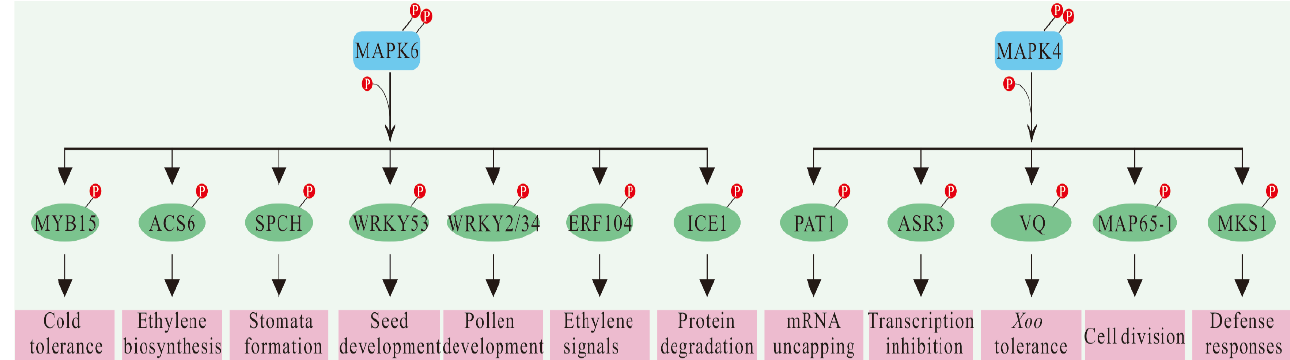
Figure 4. Schematic diagram for MAPKs and substrates in multiple plant signaling events. The examples of MPK4 and MPK6 are shown on the left and right panels, respectively. Moreover, SPCH, WRKY34, ICE1, and MYB15 were also phosphorylated by MPK3. The circled P indicates phosphorylation.